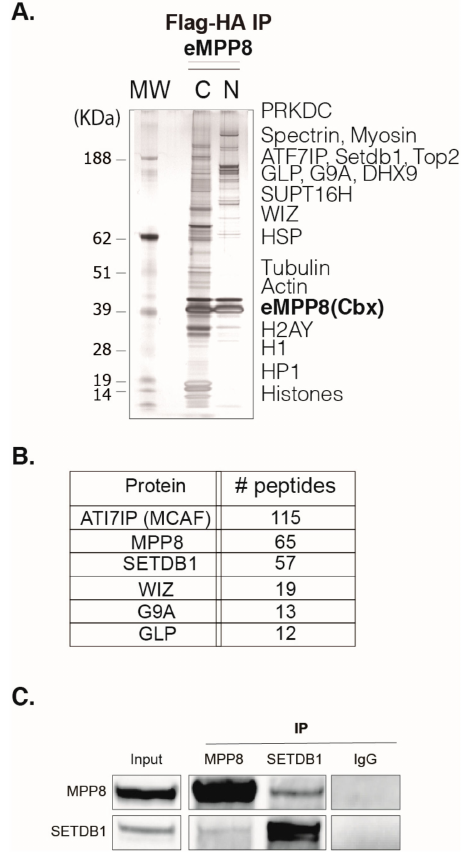
Figure 1. MPP8 complex characterization. ( A ) Silver staining of MPP8 complex. The double immuno- purification of MPP8-choromobox complex has been performed from either chromatin-enriched (C) or nuclear soluble (N) extracts of HeLa-MPP8-chromobox cells. Eluted eMPP8 (cbx) complexes were resolved on a 4–12% gradient of Sodium dodecyl sulfate polyacrylamide gel electrophoresis (SDS-PAGE). Note that we have loaded ten times more eMPP8 soluble complex (N) than chromatin-associated complex (C). MW, molecular weight marker, in KDa. ( B ) Scores of the top most abundant peptides as identified by MS. ( C ) Endogenous MPP8 and SETDB1 interact in mESCs. Nuclear extracts from HM1 mESCs were used for immunoprecipitation (IP) with the indicated Abs; IgG was used as negative control. The resulting precipitates were then subjected to western blot (WB) with indicated